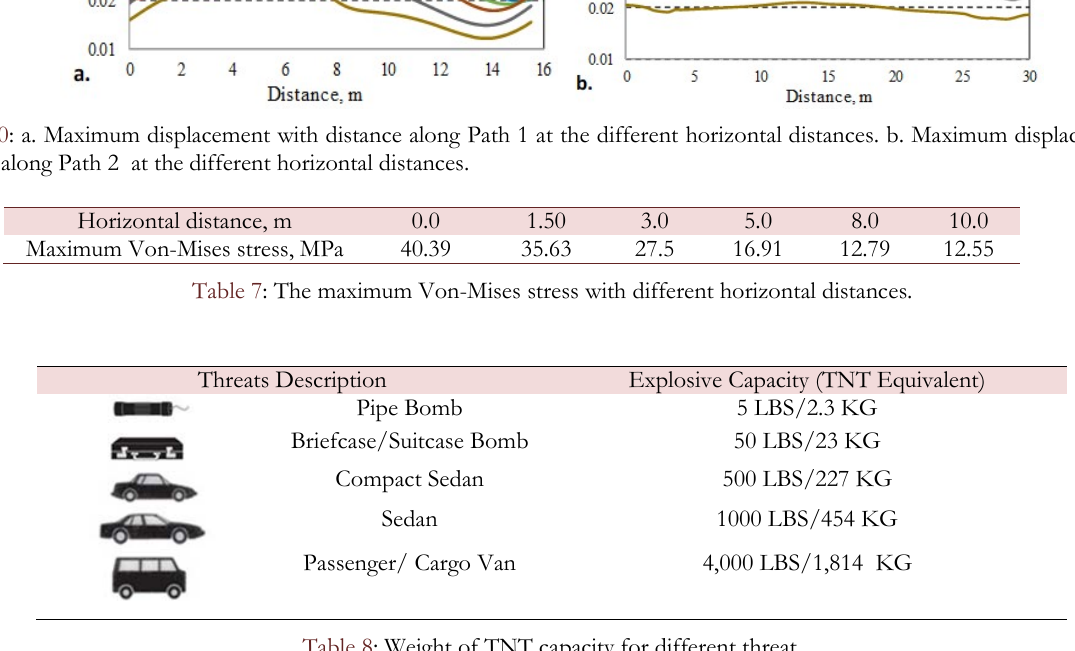
Table 8: Weight of TNT capacity for different